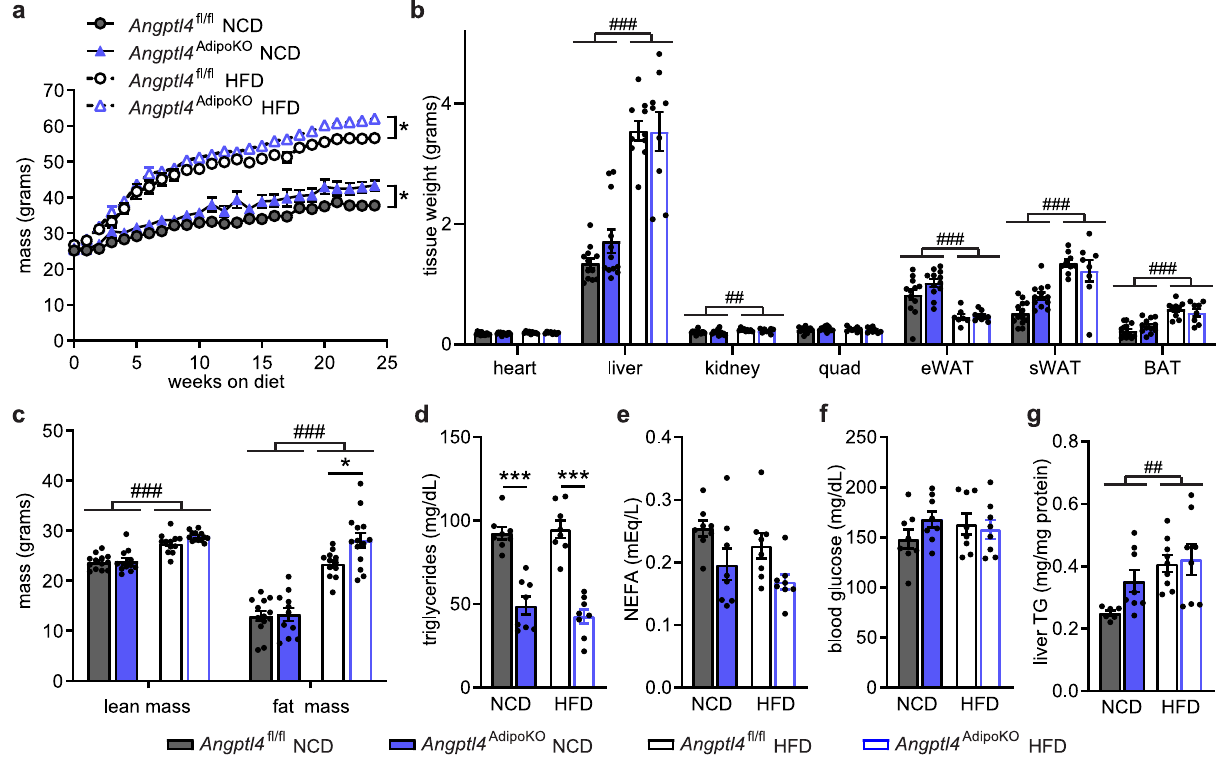
Figure 5. Body weights, fat mass, and metabolic phenotypes of Angptl4 fl/fl and Angptl4 AdipoKO mice after chronic high-fat feeding. ( a ) Weekly body weights of male Angptl4 fl/fl and Angptl4 AdipoKO mice fed either a normal chow diet (NCD) or high fat diet (HFD) for 6 months starting at 8 weeks of age (mean ± SEM; n = 10–17/group). *p < 0.05 by repeated measures ANOVA. ( b ) Tissues weights of heart, liver, kidney, quadriceps muscle (quad), epididymal white adipose (eWAT), subcutaneous white adipose tissue (sWAT), and brown adipose tissue (BAT) in male Angptl4 fl/fl and Angptl4 AdipoKO mice after 6 months on diet (mean ± SEM; n = 8–13/group). ( c ) Lean muscle mass and fat mass of male Angptl4 fl/fl and Angptl4 AdipoKO mice as measured by NMR after 24 weeks on diet. (mean ± SEM; n = 11–14/group). Plasma triglycerides ( d ), plasma non-esterified fatty acids ( e ), blood glucose ( f ), and liver triglycerides ( g ) of fasted (6 h) male Angptl4 fl/fl and Angptl4 AdipoKO mice after 6 months on diet (mean ± SEM; n = 8–9/group). ##p < 0.01, ###p < 0.001 for dietary differences by two-way ANOVA. *p < 0.05,***p < 0.001 for individual genotype-specific differences by multiple comparison after two-way ANOVA (Tukey